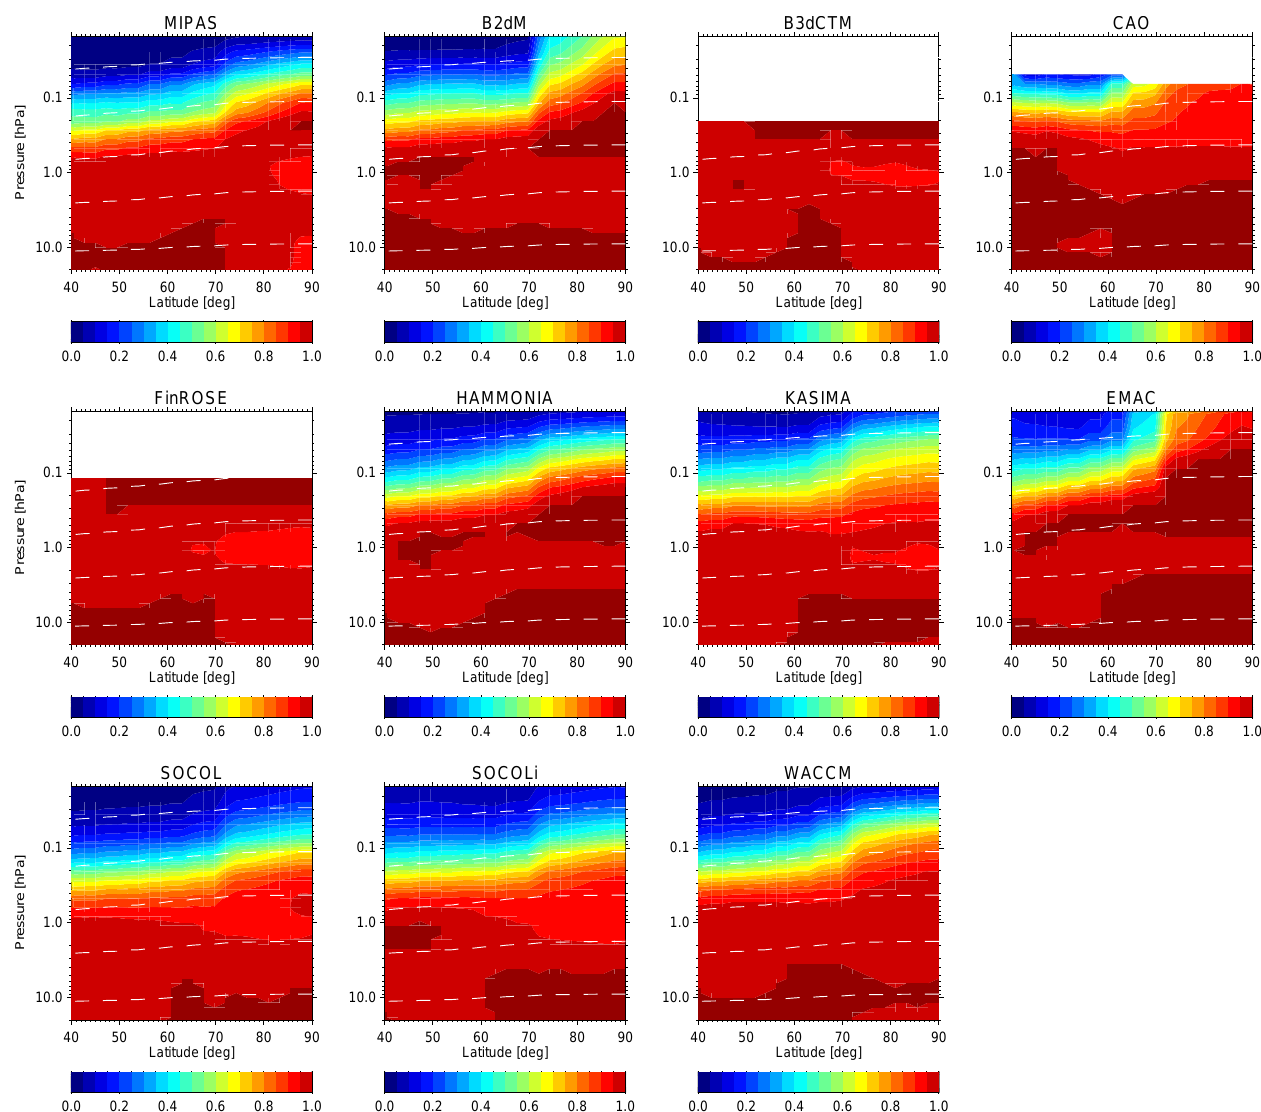
Fig. 19. Zonal mean nighttime NO 2 /NO x ratios averaged over the period 28 October–15 November in MIPAS observations and model